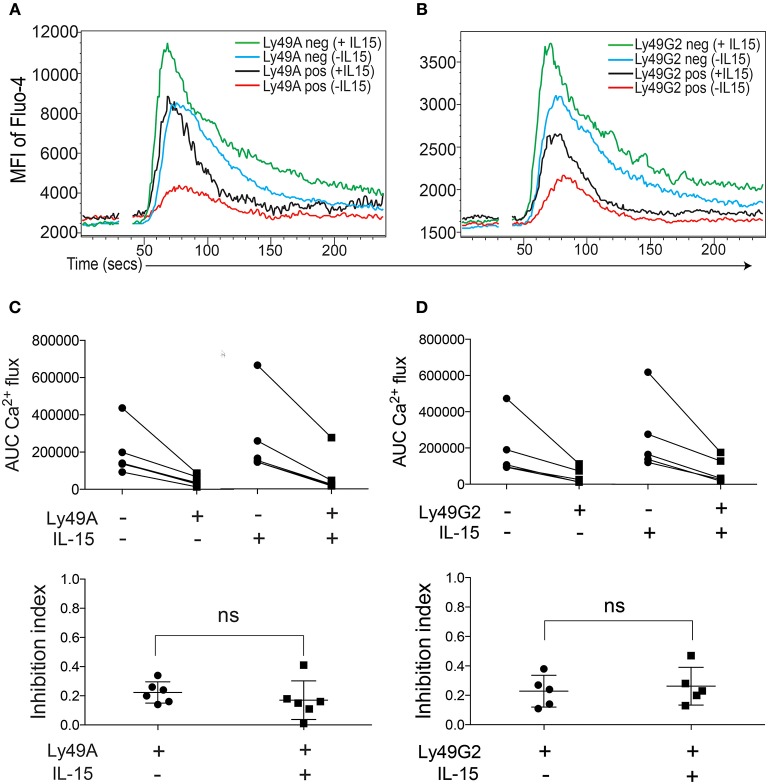
IL-15 priming does not abrogate the capacity of inhibitory receptor crosslinking to dampen Ca2+ flux in B6 NK cells. (A) One representative experiment showing kinetics of Fluo-4 fluorescence in Ly49A+ and Ly49A− IL-15-primed or non-primed NK cells. (B) Same as in (A) but gated on Ly49G2+ NK cells. (C) Top: Total AUC values after baseline correction of Ly49A− and Ly49A+ NK cells with or without IL-15 from 6 independent experiments. Lines connect subsets from the same experiment. Bottom: Inhibition index for anti-Ly49A crosslinking in IL-15-primed and non-primed NK cells. (D) Same setup as as in (C) but for Ly49G2+ NK cells. ns , not significant.